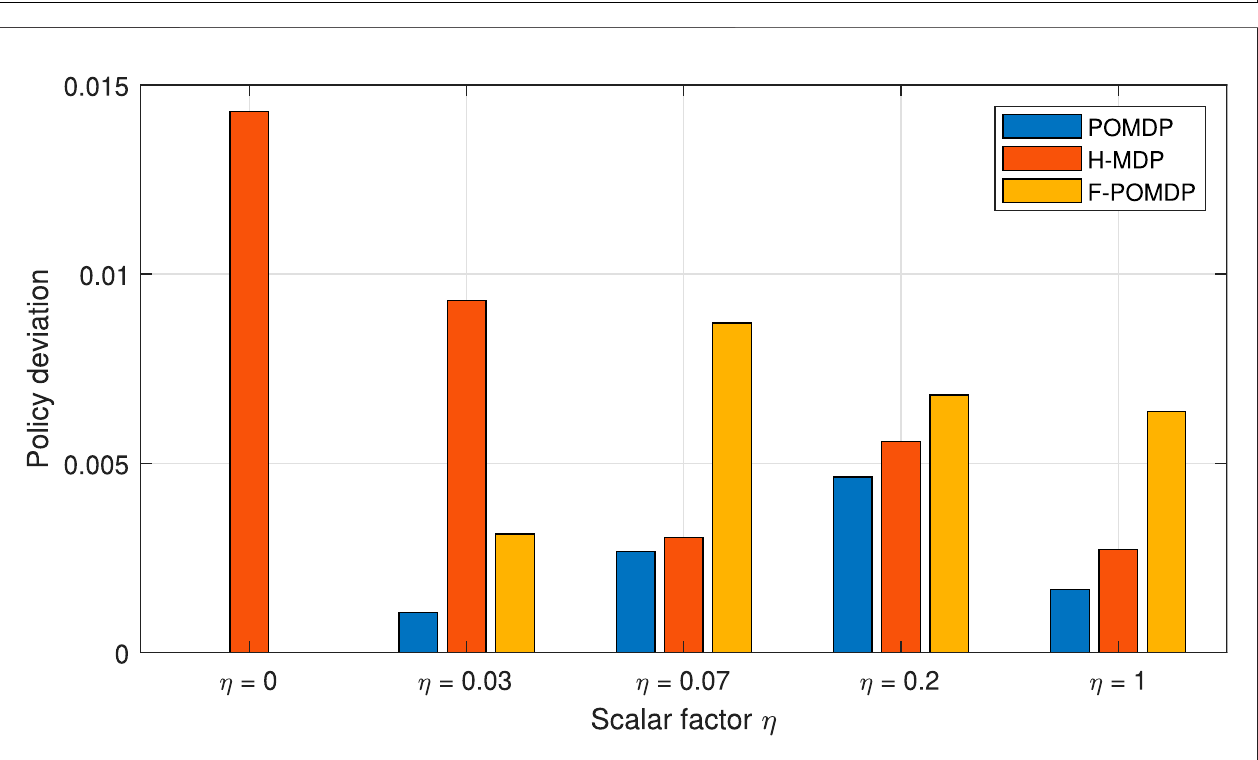
Frontiers in Communications and Networks |